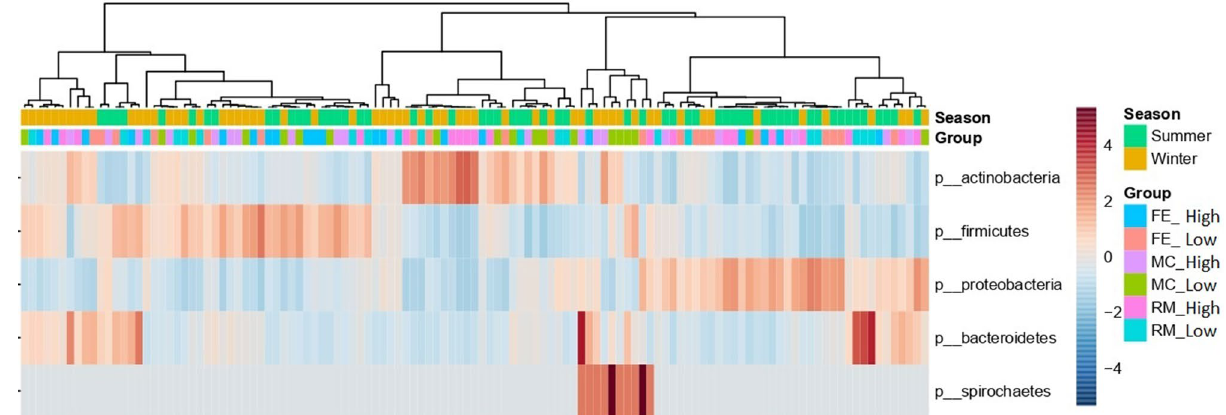
Figure 3. Heat map based on the relative abundance of bacteria among the groups and seasons at the phylum level using the linear discriminant analysis (LDA) effect size